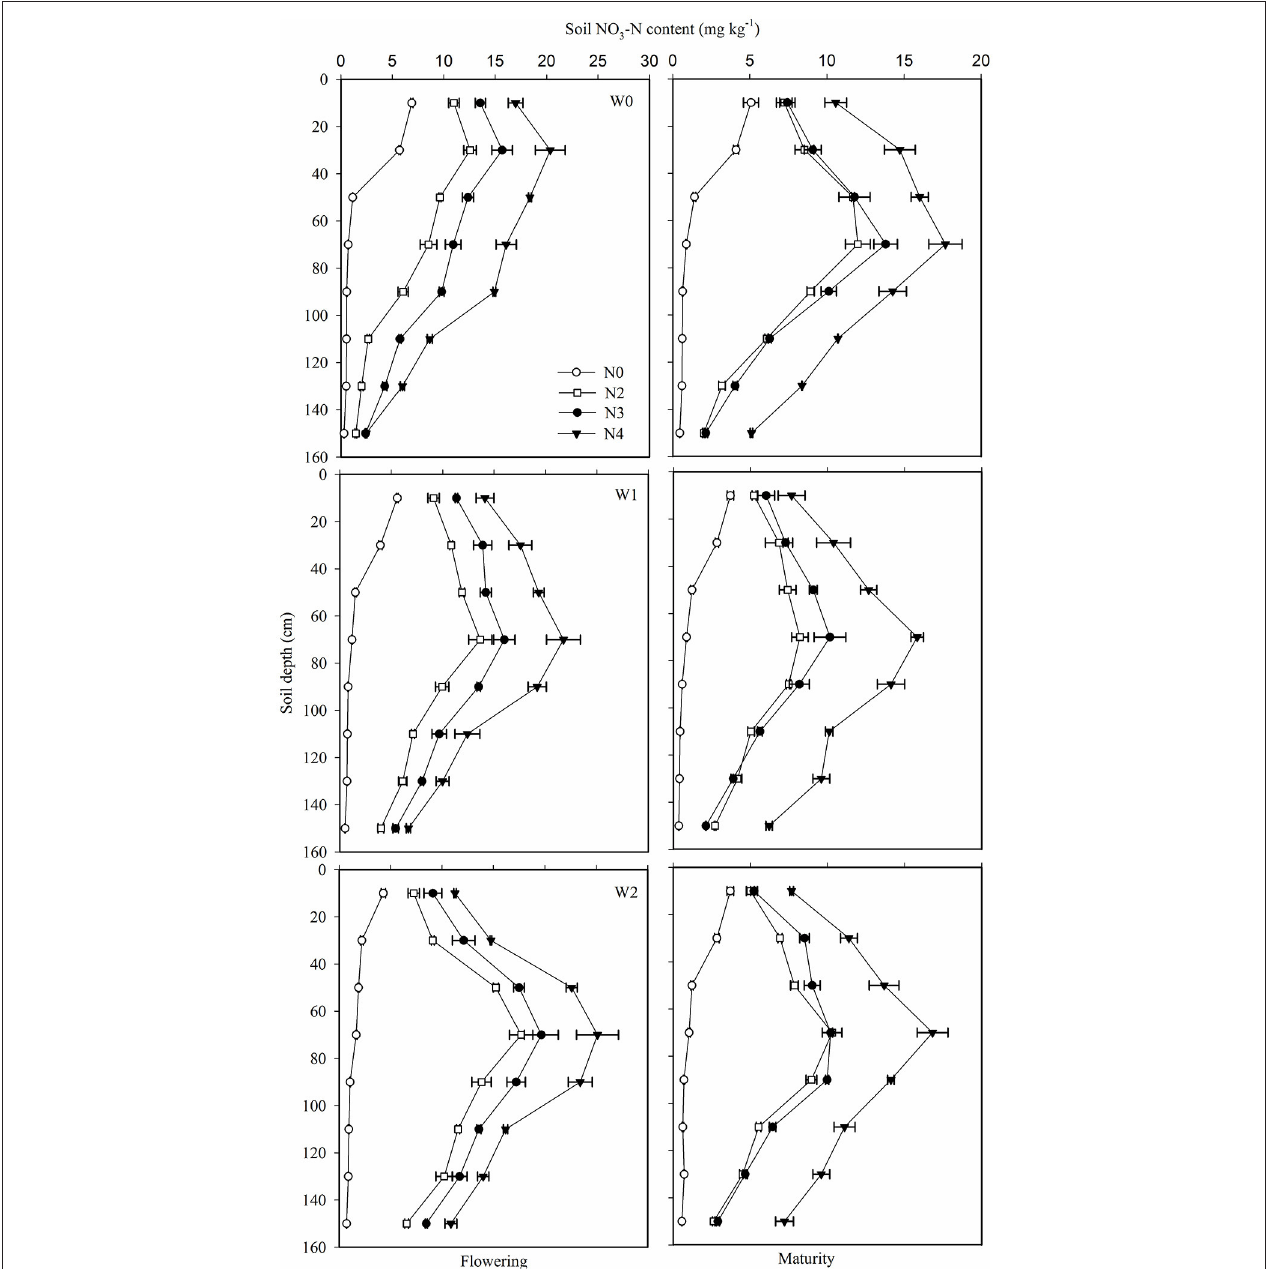
FIGURE 4 | Effect of irrigation and nitrogen regimes on NO 3 -N content at flowering (left panels) and maturity (right panels) at 0.2m increments to a depth of 1.6m in the 2013–2014 growing season. Horizontal bars represent the standard